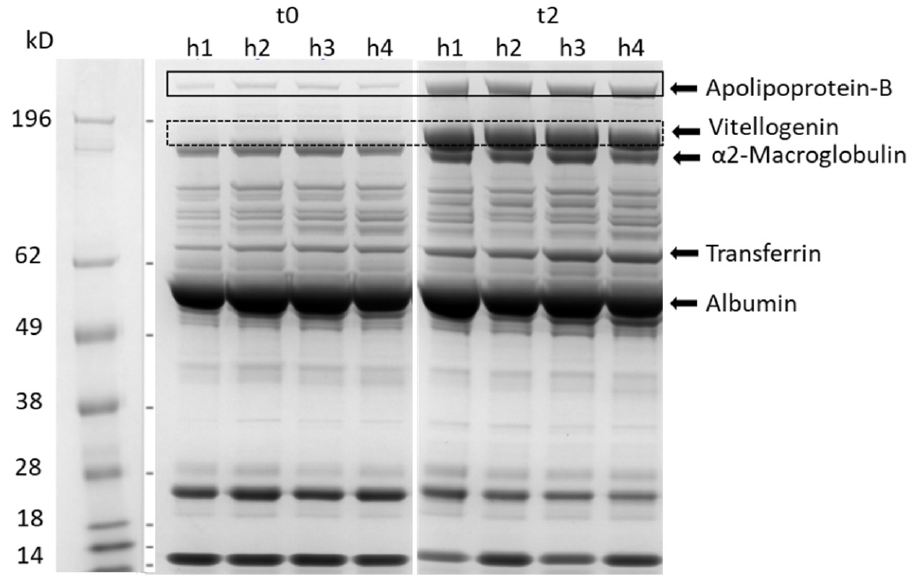
Figure 2. Representative gel of serum proteins using SDS–PAGE obtained from the same 4 control hens (h1–h4) at t0, start of the trial (before the laying phase) and at t2, 12 weeks later (hens in laying phase). The molecular mass (kD) of marker proteins is shown to the left of lane 1. Putative proteins are identified based on the MM and the position on the gel.